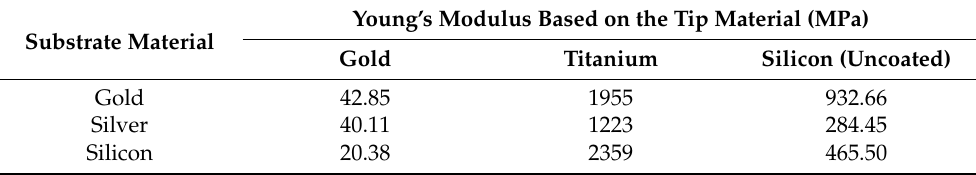
Table 5. Values of Young’s modulus of substrates obtained by various tip